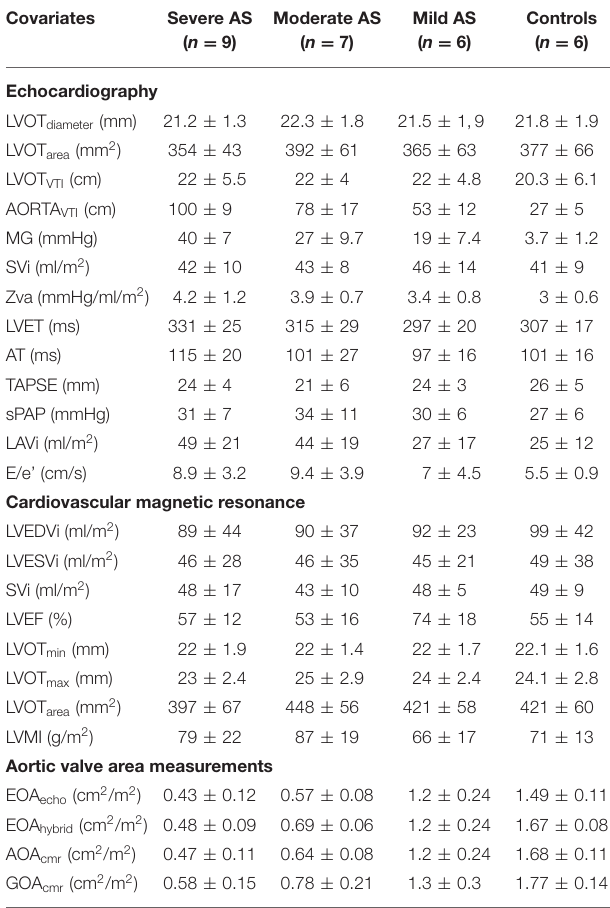
TABLE 2 | Echocardiographic and CMR